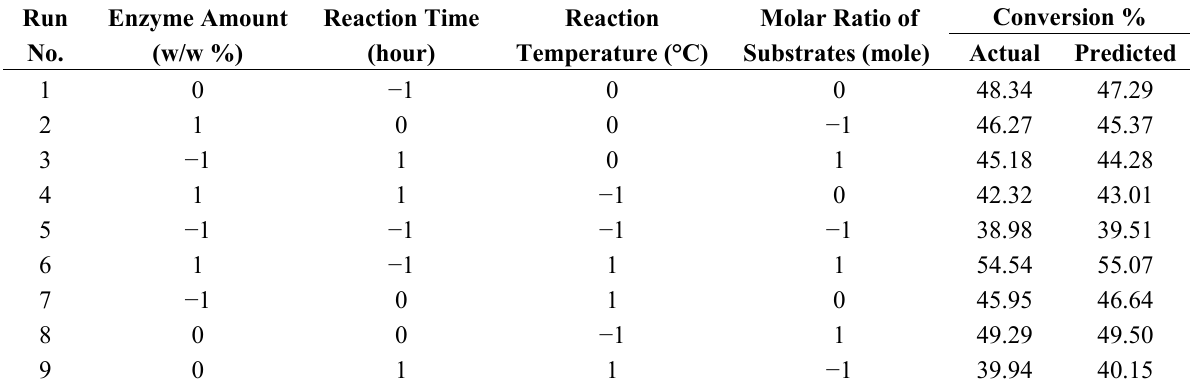
Table 1. Experimental data for lipase-catalyzed synthesis of TEA-based esterquat cationic surfactant with the predicted values.